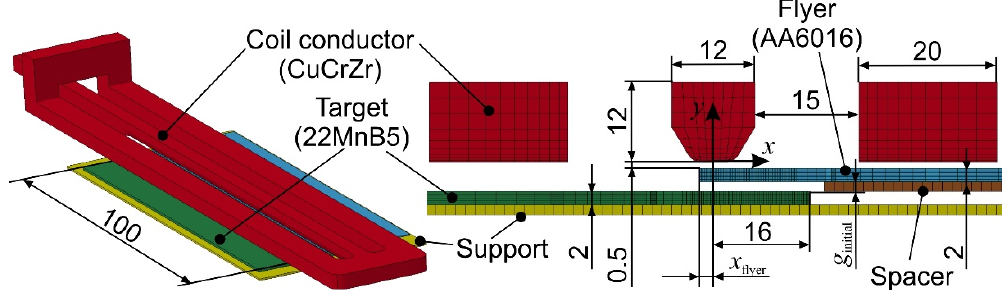
Figure 4. Discretization of the numerical model.